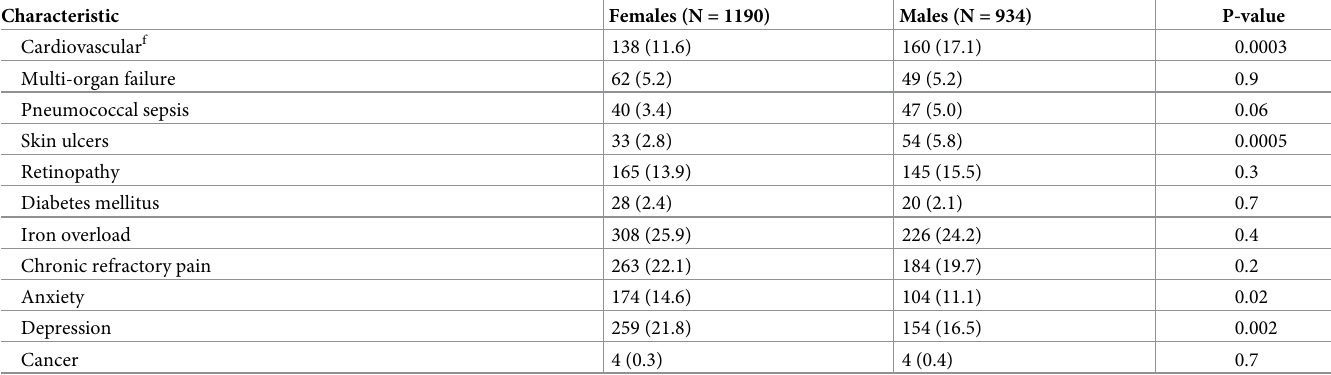
Missing values were not included in the comparison. The p-values reported represent strength of associations between variables. a Digestive complications: splenomegaly, splenic sequestration, splenic infarcts, hypersplenism, autosplenectomy, gallstones and cholecystitis. b Musculoskeletal complications: dactylitis, avascular necrosis and osteomyelitis. c Autoimmune/Inflammatory complications: deep venous thrombosis, lupus, rheumatoid arthritis, gout and sarcoidosis. d Central nervous system complications: stroke and intracranial bleeding. e Genitourinary complications: priapism, chronic kidney disease and end stage renal failure. f Cardiovascular complications: pulmonary arterial hypertension and left ventricular